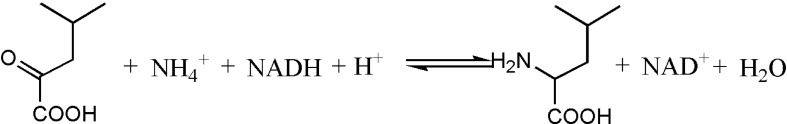
LeuDH catalyzes the synthesis of corresponding amino acids from ketoacid.